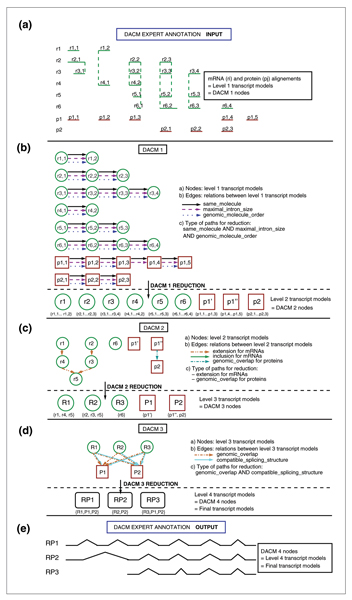
Example of transcript modeling from a set of protein and mRNA alignments using DACMs. (a) The DACM input are mRNA (r1...r6) and protein (p1, p2) sequences that have been aligned to a genomic sequence S. The individual local alignments are each a level 1 transcript model (L1TMs)and constitute the nodes of a graph DACM1. (b) This graph has three possible directed edges: same_molecule, maximal_intron_size, and genomic_molecule_order. Each corresponds to a different relationship that connects two nodes if they respectively: are alignments produced by the same mRNA or same protein; are separated by a distance smaller than a user defined threshold (for example, 75 kilobases); and are collinear on the molecule of origin (mRNA or protein) and the genomic DNA. There are nine maximal paths along the three combined edges, which reduce DACM1 into the nine nodes (r1 to r6 and p1', p1", p2) of a graph DACM2, each representing a level 2 transcript model (L2TM). Note that the reduction of DACM1 splits nodes p1,1 to p1,5 into two DACM2 nodes (p1' and p1) because of the absenceof a genomic_molecule_order edge between p1,3 and p1,4. (c) DACM2 has three possible edges, inclusion, extension (for mRNAs) and genomic_overlap (for proteins), which respectively connect two nodes if: they overlap and their overlapping introns are identical; they overlap and their overlapping introns are identical but the second node also extends the first in 3'; and the span of the two nodes have overlapping genomic coordinates. The reduction follows either the 'extension' rule for mRNAs edges or the genomic_overlap protein edge and produces here the five nodes of graph DACM3 (mRNA nodes R1 to R3 and protein nodes P1 and P2), which represent level 3 transcript models (L3TMs). (d) DACM3 has two possible edges, genomic_overlap and compatible_splicing_structure, whichconnect (combines) protein and mRNA transcript models if they respectively have overlapping genomic coordinates and if the protein transcript model does not have any exons in introns of the mRNA transcript model. To reduce the graph, Exogean first identifies the path that contains both edges and from these, the reduction consists in grouping all nodes that are connectedto the same RNA node. This generates the three nodes of a graph DACM4 (RP1 to RP3), which represent level 4 transcript models (L4TMs). These L4TMs arethe final transcript models generated by the DACM expert annotation. (e) Graphical representation of the DACM expert annotation output: the final transcript models RP1 to RP3 are represented on the genomic sequence S. No information has been lost during the three graph reductions. Note that transcript models produced by the DACM component of Exogean are not yet final, and will be further examined and potentially extended when looking for splicing and start/stop signals.